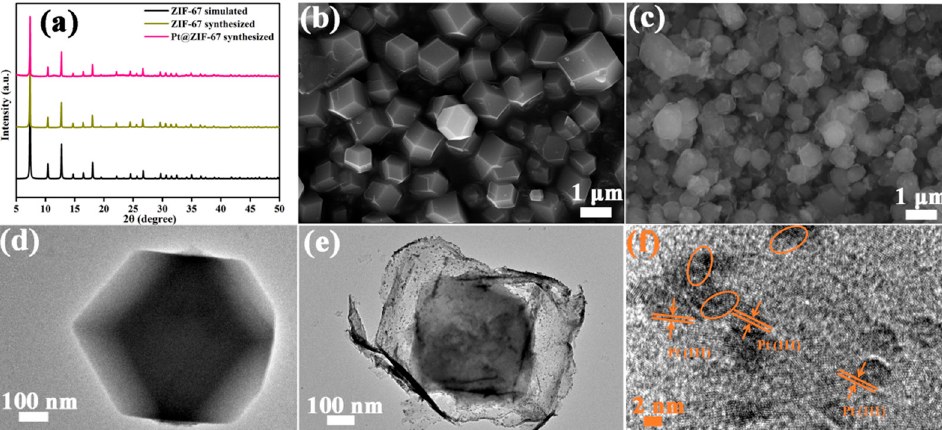
Figure 2. ( a ) XRD patterns of ZIF-67 and Pt@ZIF-67. ( b , c ) SEM images of ZIF-67 and Pt@ZIF-67. ( d ) TEM image of ZIF-67. ( e , f ) TEM and HRTEM images of Pt@ZIF-67.